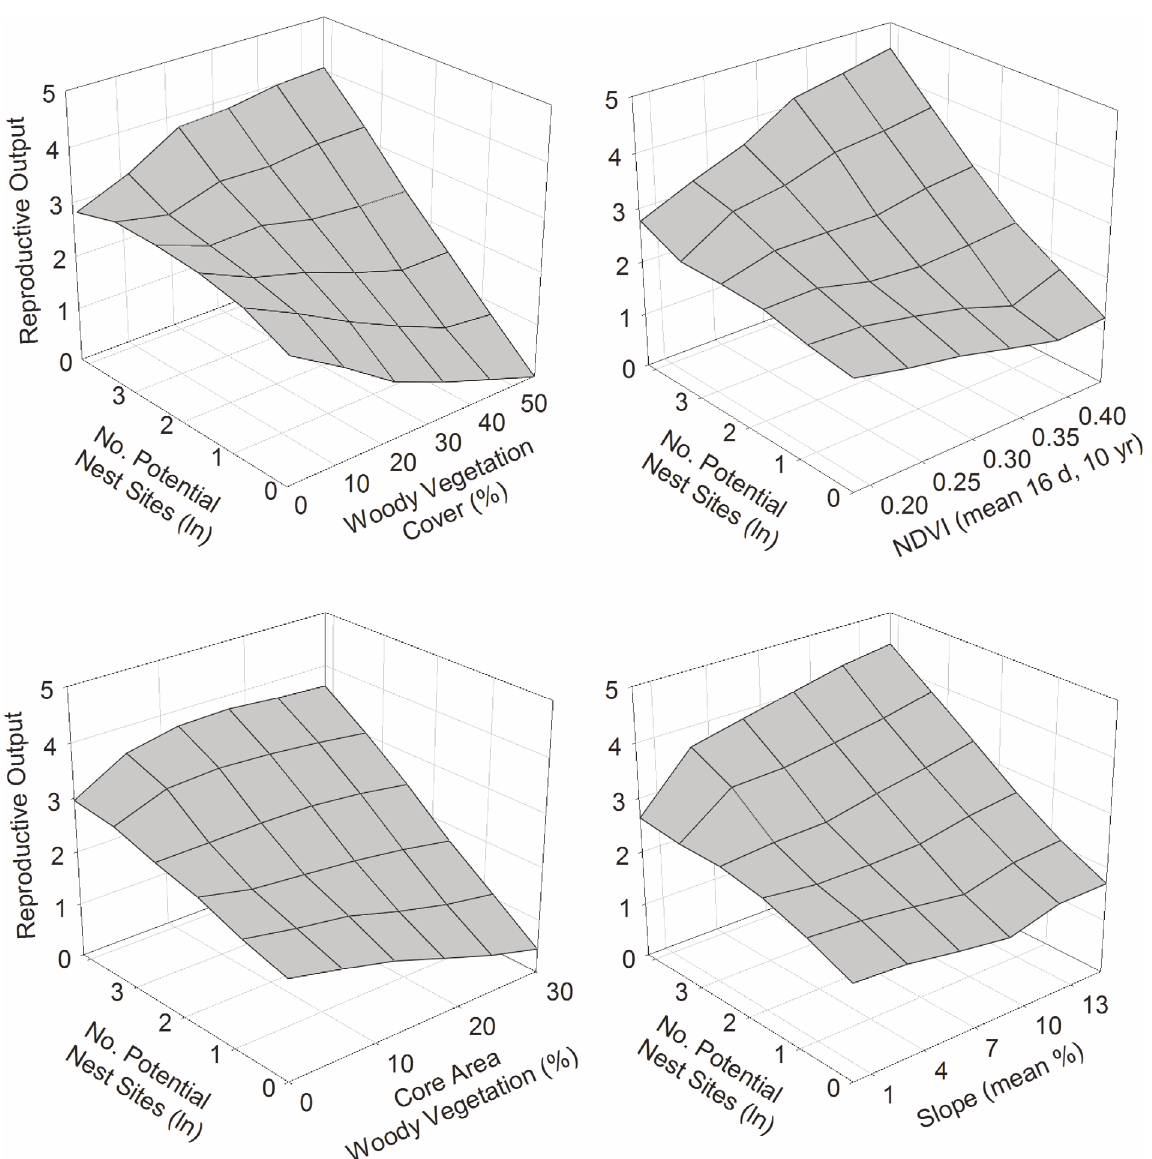
Fig 3. Effect of habitat factors on reproductive output of ferruginous pygmy-owls in northwest Mexico, 2001 – 2010. Lower right figure shows the number of negative heterospecific interactions observed divided by the total number of territory patches in each group across a gradient of increasing abundance of potential nest sites. Filled circles in upper figures are patches in semi-desert grasslands whereas those in the lower figure are patches where we observed negative heterospecific interactions. Estimates of reproductive output are based on model 3 in Table 3. Inset in upper left figure shows means ( ± SE) in each vegetation